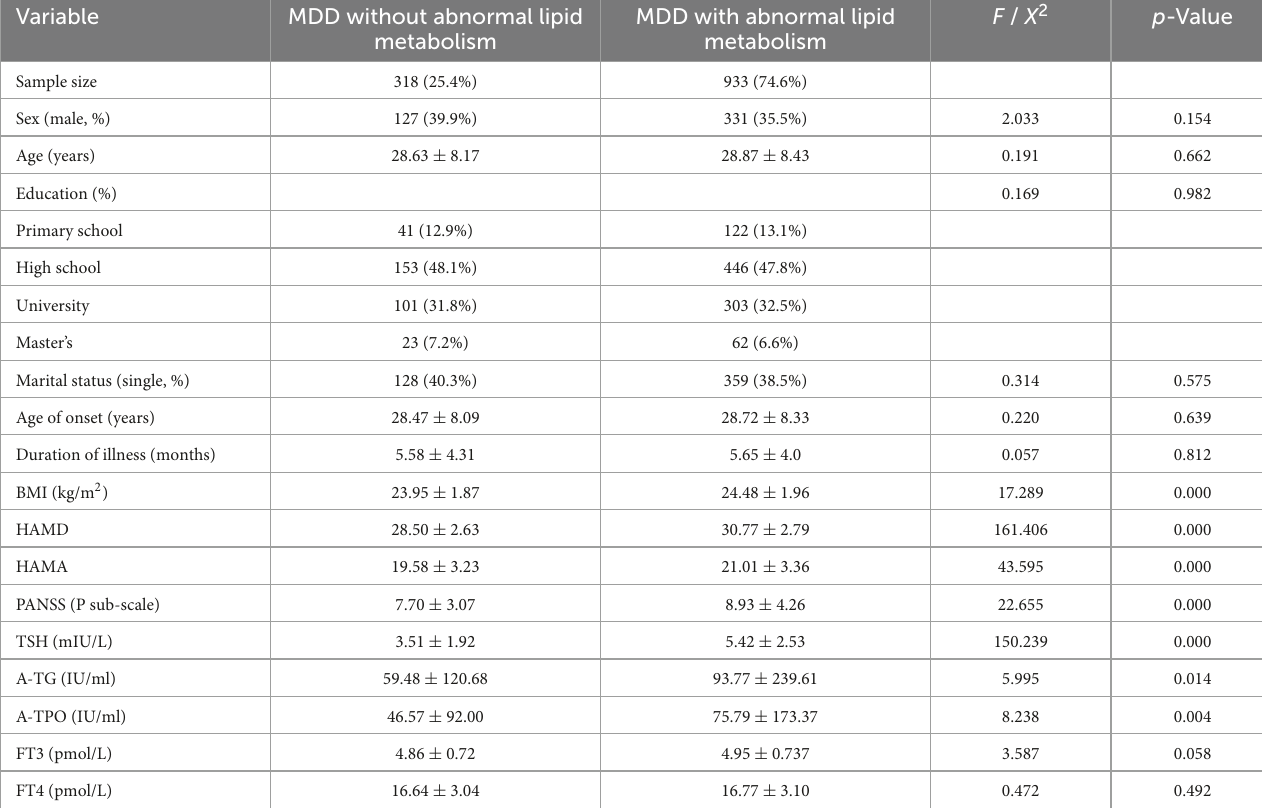
TABLE 1 Comparison of demographic and clinical characteristics between young adult FEDN MDD patients with and without abnormal lipid metabolism. Variable MDD without abnormal lipid MDD with abnormal lipid metabolism